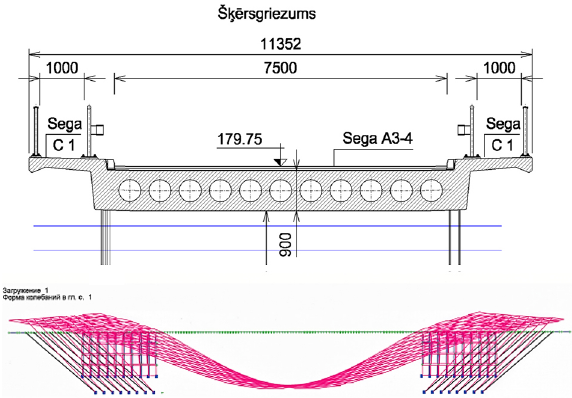
Fig. 10. Cross section and first mode shape of a bridge on A12 over railroad Rīga–Rēzekne. FE model constructed